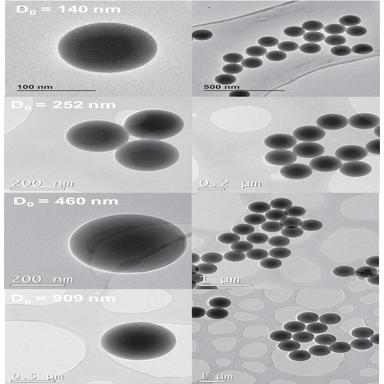
TEM analysis of PS NPs with different particle sizes.